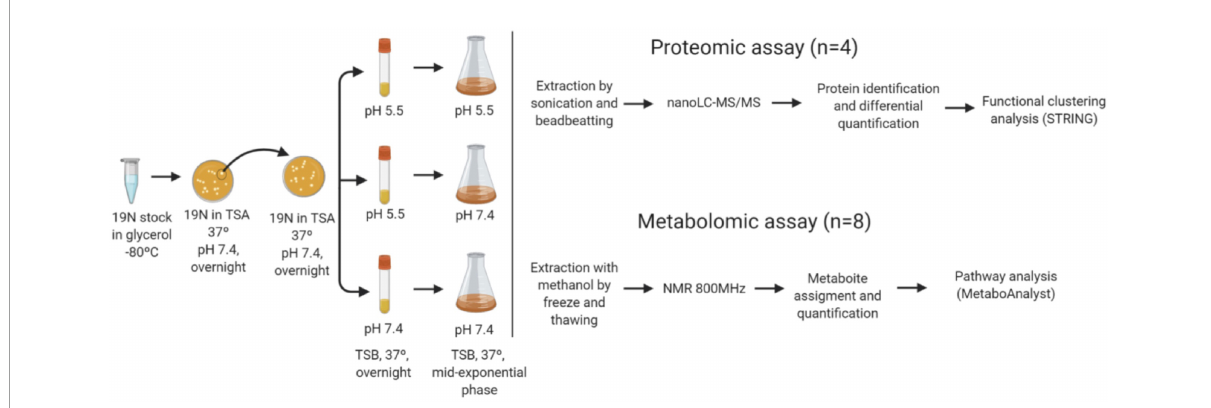
FIGURE1 Scheme of the workflow followed. Cells from –80 ◦ C glycerol stocks were streaked in Tryptic Soy agar media (TSA) and a single colony was picked to inoculate a new TSA plate. From the plate a single colony was collected to prepare a pre-inoculum in TS broth medium with adjusted pH (pH 5.5 and 7.4) and incubated overnight at 37 ◦ C and 225 rpm. The inoculum at pH 5.5 was used for the cultures grown at 5.5 (N55) and 7.4 (N57), and the inoculum at pH 7.4 for the culture at the same pH (N77). The cells were harvested at mid-exponential phase. For proteomics the proteins were extracted from 4 biological replicates/experimental condition and analysed by nanoLC-MS/MS. Identified proteins (MASCOT) were quantified by spectral counts. Differential abundant proteins between experimental conditions were submitted to functional clustering analysis (STRINGdb). Metabolites from eight replicates/experimental condition were extracted, after metabolic quenching and biomass normalisation. Metabolites were assigned in 1 H-NMR spectra acquired in an 800 MHz spectrometer (ChenomxNMRsuite). Their determined concentrations were used for pathway analysis